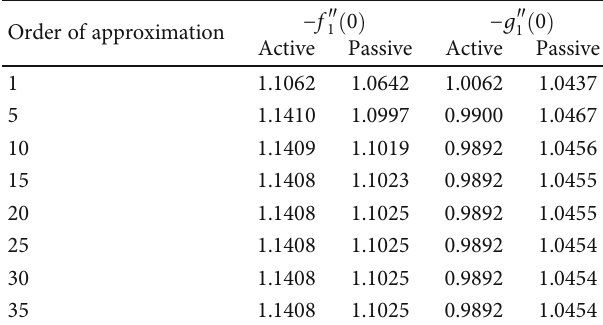
″ ð 0 Þ and − g ″ ð 0 Þ . 1 1